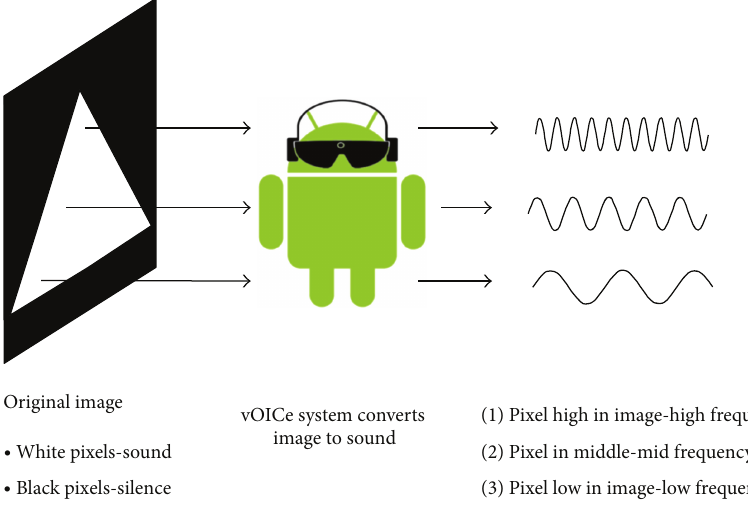
Figure 1: Conversion of image to sound using The vOICe algorithm. White pixels in the image are represented by a sound with black pixels silent. The elevation of each pixel is coded by frequency with pixels higher in the image having a higher frequency sine wave. All pixels in a vertical raster line are played simultaneously with a 1 second left-to-right horizontal scan across image resulting in the soundscape for the